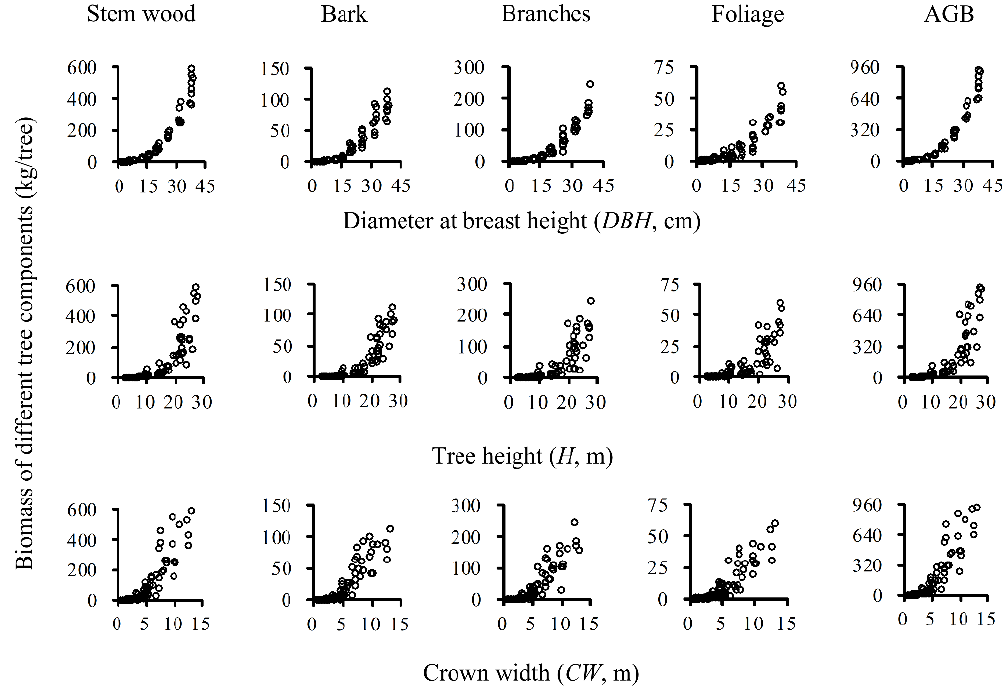
Figure 1. The relationships between the biomass components versus tree level variables for poplar in Jiangsu Province of China ( n = 80).